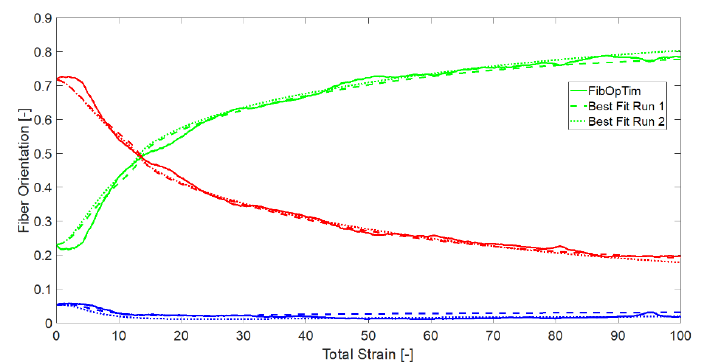
Figure 3. Fiber orientation evolution for a shear rate of 1 s −1 and parameters set as V15.